Question: Provide a one-line summary of what is displayed.
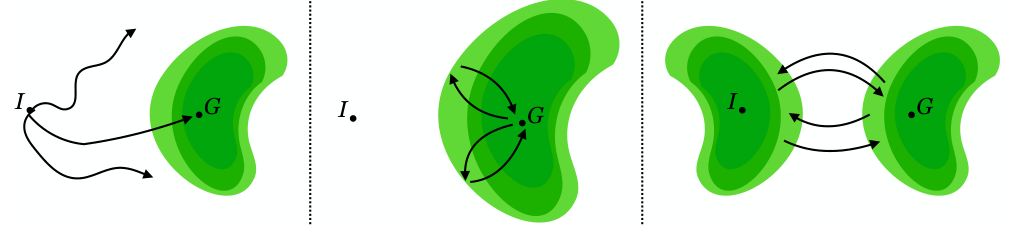
Answer: In RL, the agent usually starts learning about the task in areas around rewarding states, and eventually propagates the learning to other parts of the state space. (Left) In episodic learning, the agent starts its trajectories at a state in the initial state distribution. Through exploration, it might find a trajectory that produces a reward, but might struggle to reach that goal state again, particularly on sparse reward or long horizon tasks. (Center) A common approach in Reset-Free RL is to build a curriculum outward from the task’s goal states. While this allows the agent to frequently visit rewarding states, it also means the majority of the agents experience will be generated in areas it has already learned. (Right) RISC switches directions when it feels confident in its ability to achieve its current goal (both in the forward (task’s goal states) or the backward direction (task’s intial states)). This not only reduces the time spent in already explored regions of the s